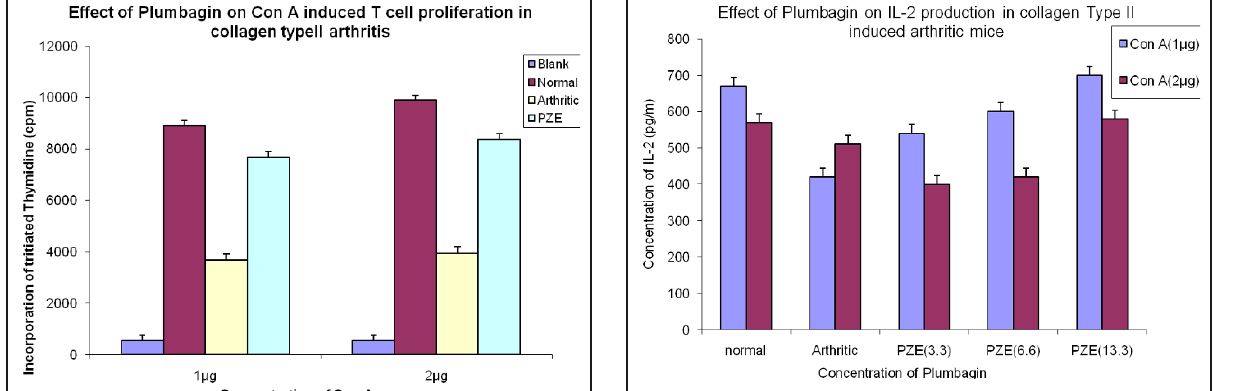
Figure 5 Effect of Plumbagin on IL-2 production in collagen Type II induced arthritis mice . Four groups of DBA/1 mice were immunized with 0.1 ml of bovine type II collagen intradermally at the base of the tail. Booster dose was given 3 weeks after primary immunization. Normal group did not receive any injection. Test groups were treated intraperitoeally with Plumbagin (3.3 mg/kg), (6.6 mg/kg) and (13.3 mg/kg) respectively. Control group was treated with vehicle alone. At the end of the experiment, mice were sacrificed and Spleenic T lymphocytes isolated from arthritic mice, PZE treated mice and normal mice were incubated with 1 μ g and 2 μ g of Con A and maintained the conditions similar to the previous culture experiments. Cultures supernatants were collected and IL-2 production was estimated by ELISA. p-value ≤ 0.05 was significant.